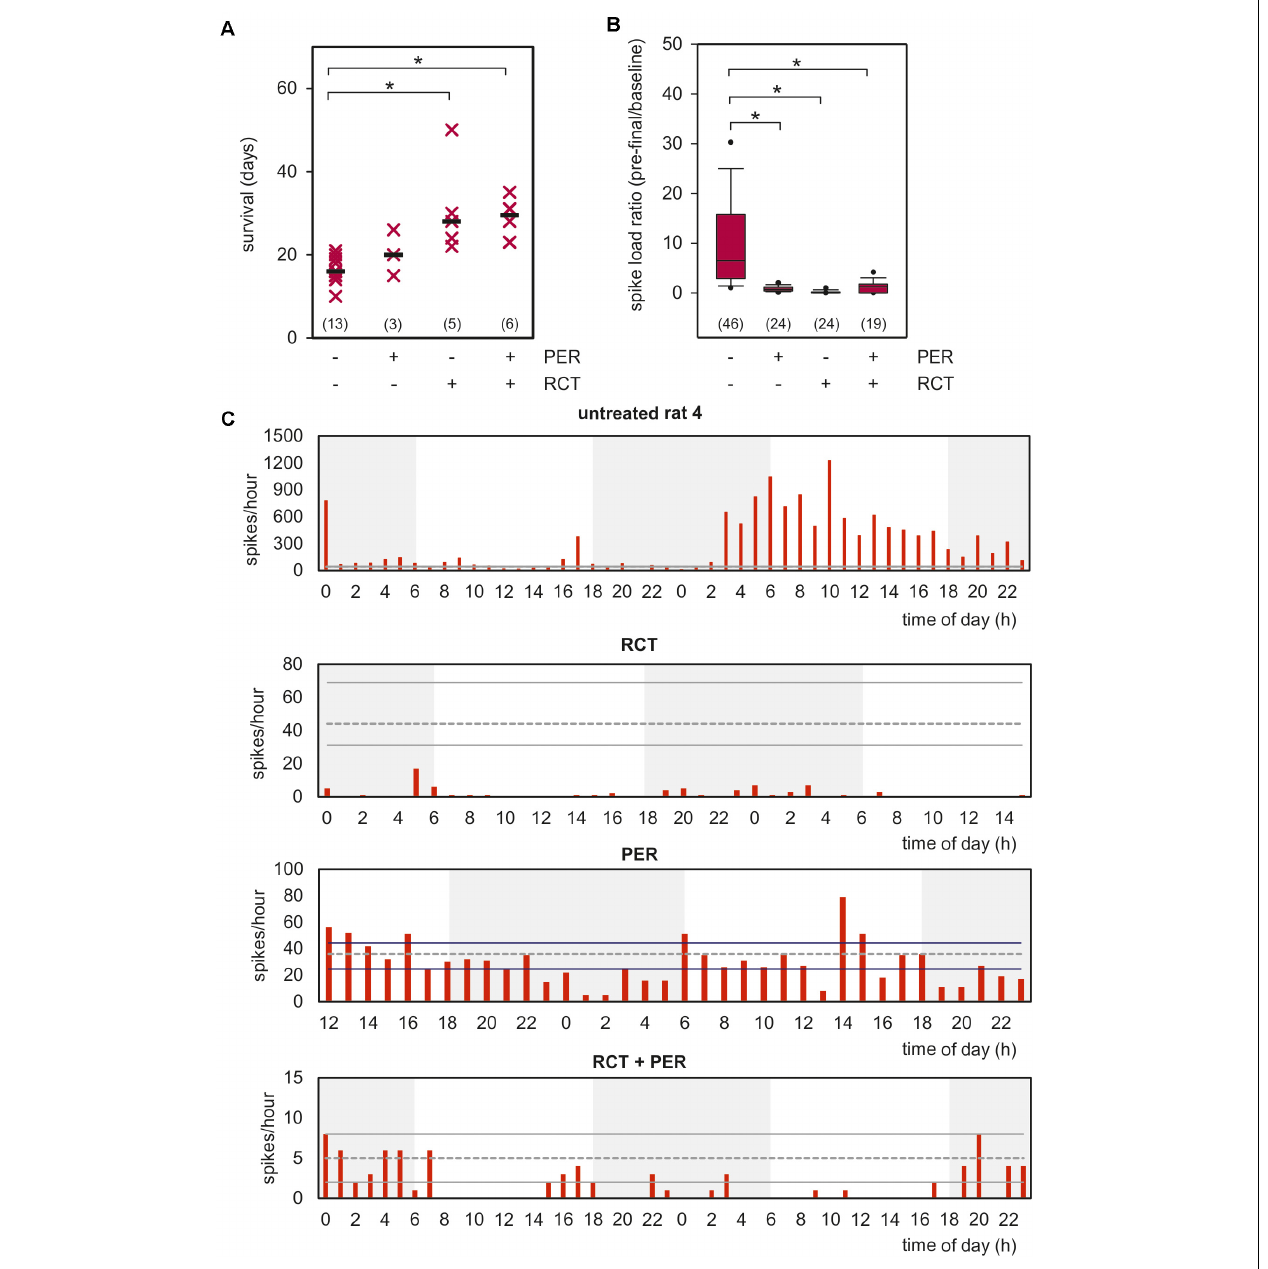
FIGURE 2 | Impact of PER, RCT, and adjuvant PER treatment to RCT on clinical progression. (A) Rats with orthotopically-growing F98 glioma were sacrificed when endpoint criteria of the experiment design were reached and survival was estimated. Survival of each animals is illustrated as single point, median is shown as black bar ( n = number of animals per group); * p < 0.05 [Kruskal–Wallis test followed by post hoc analysis (Dunn’s test)]. (B) Box plot shows video-EEG analysis of untreated animals versus RCT, PER, or RCT + PER cohorts. Data represent the number of analyzed hours in each cohort (data were obtained from 4 untreated, 2 RCT-treated, 2 PER-treated, and 2 RCT + PER-treated animals), * p < 0.05 [Kruskal–Wallis test followed by post hoc analysis (Dunn’s test)]. (C) Spike distribution over time of one animal from each investigated group is shown. Data range from 40–48 h of the last 3–4 days of the rats. Gray dotted line presents median of spikes of 12h-baseline as described in section “Materials and Methods,” whereas solid lines show upper and under